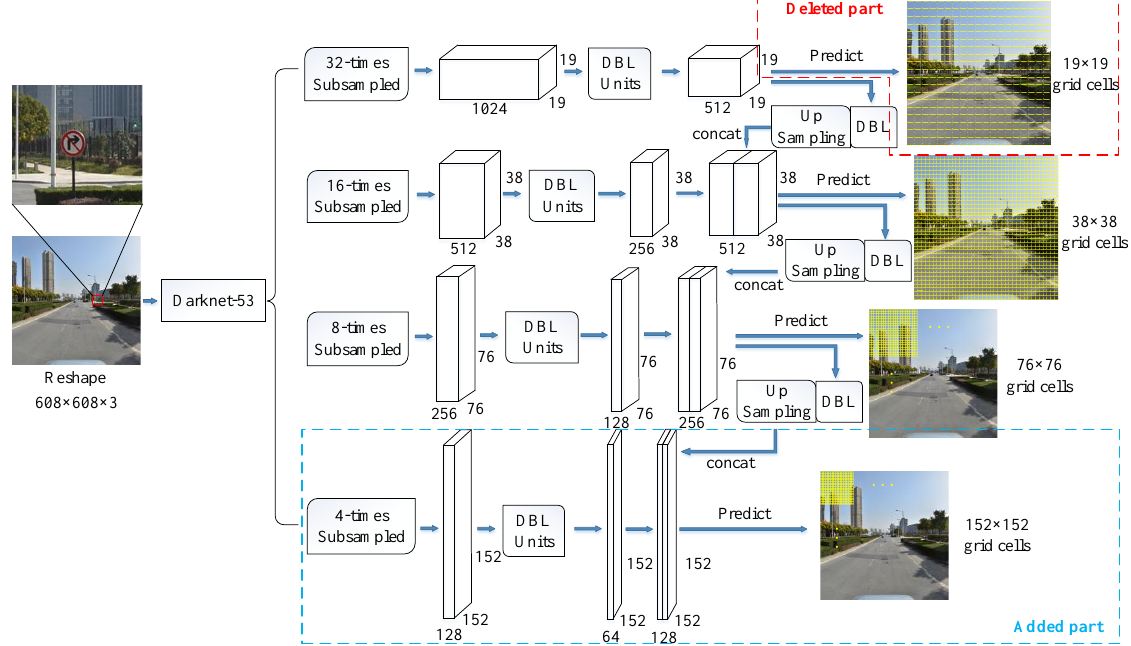
Figure 3. The structure of improved YOLOv3 (Red is the deleted part, blue is the newly added part).